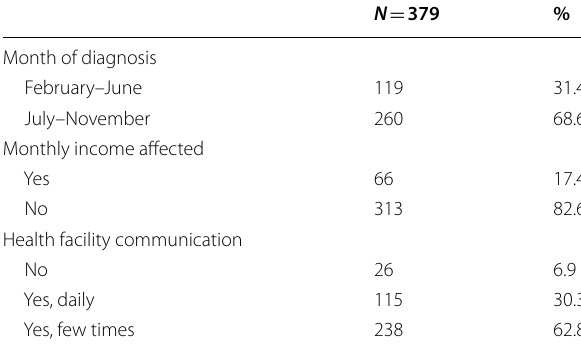
Table 1 Participant’s